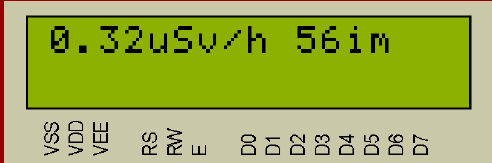
Figure 8. Simulation of the situation of exceeding the allowed radiation dose.